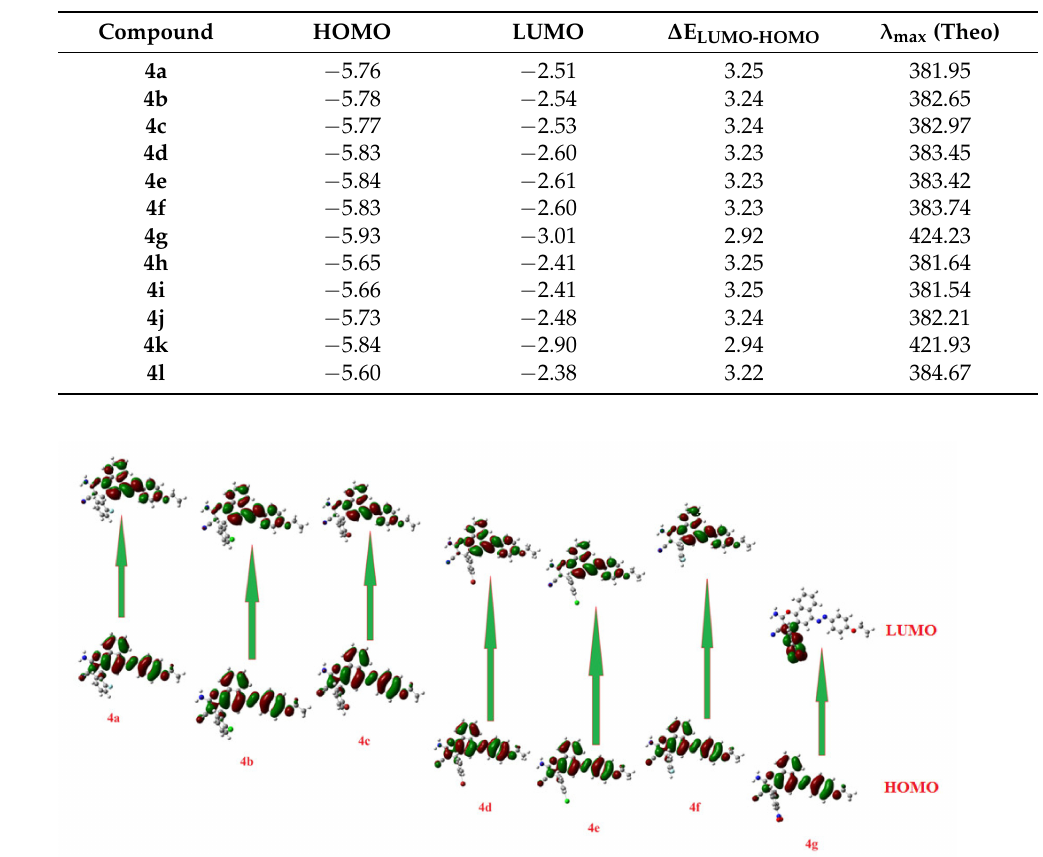
Table 1. The calculated energies of frontier molecular orbitals (FMOs), their energy gap (eV), and λ max (nm) of the prepared compounds 4a-l .